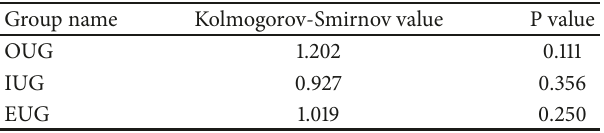
Table 9: Kolmogorov-Smirnov